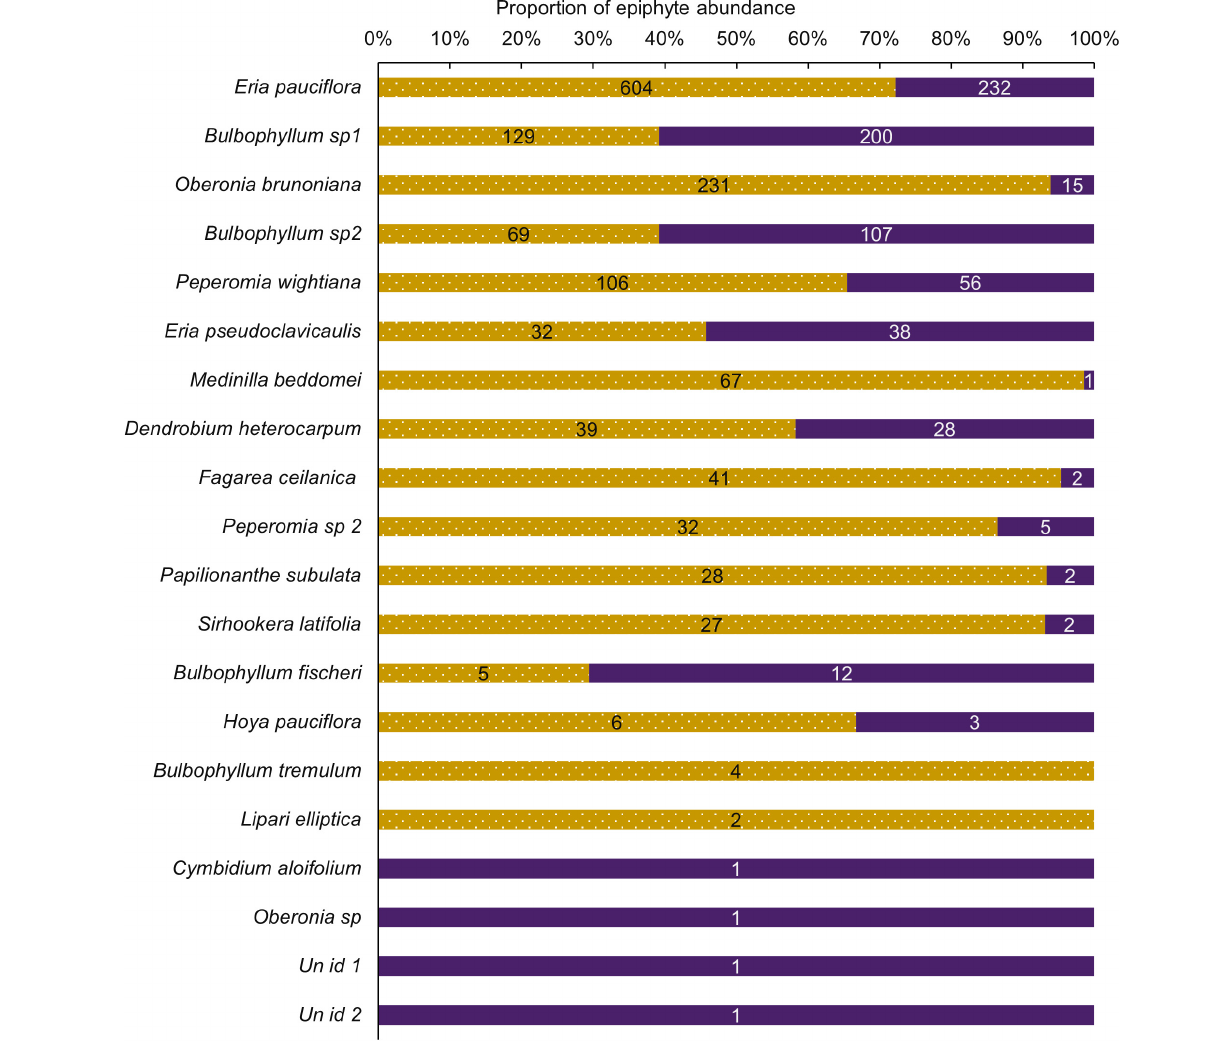
FIGURE 3 | Proportions of epiphyte species composition differed between unlogged and selective logged forests. Relative abundance of epiphytes in the unlogged (purple) and the selectively logged forest (dotted gold). The percentage of the total abundance is depicted. Actual relative abundance values are presented on